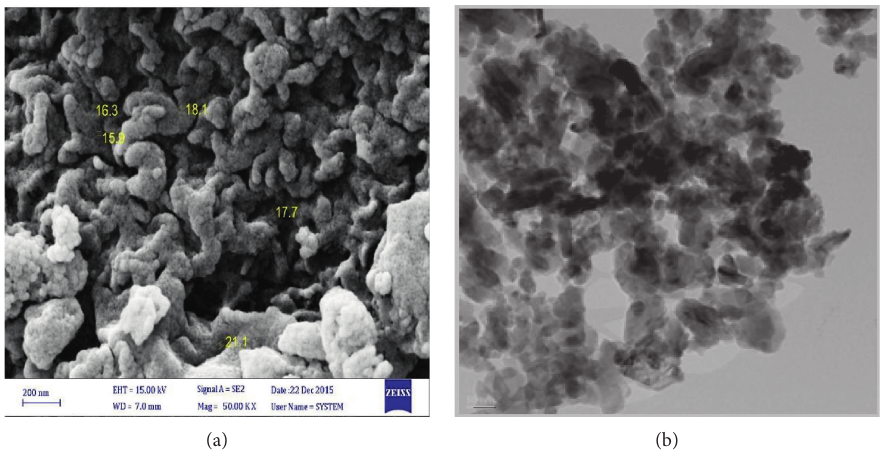
Figure 2: SEM (a) and TEM (b) images of alumina powder obtained by sol-gel method. Table 1: Comparison of mean of bone density (g/cm 2 ) among all groups (ANOVA test) and control and other groups (Tukey’s test). Groups